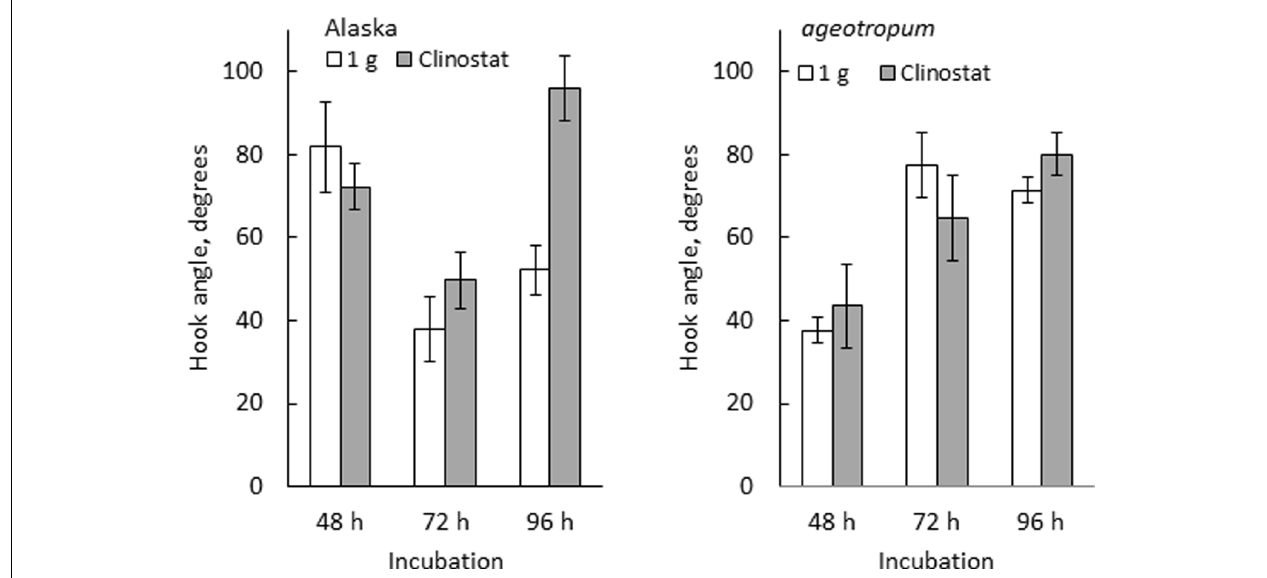
FIGURE 6 | Effects of clinostat rotation on the hook development inAlaska and ageotropum . Data bars: the means with standard errors ( n = 8–10); time: h